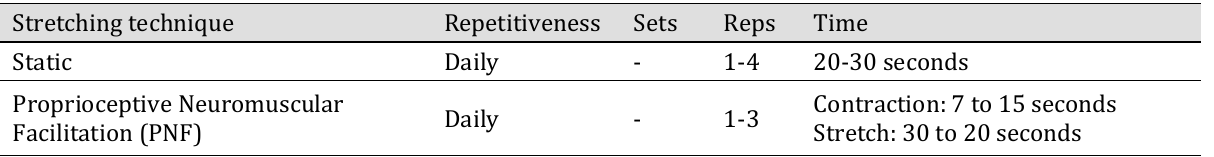
Table 2. Stretching stage technique